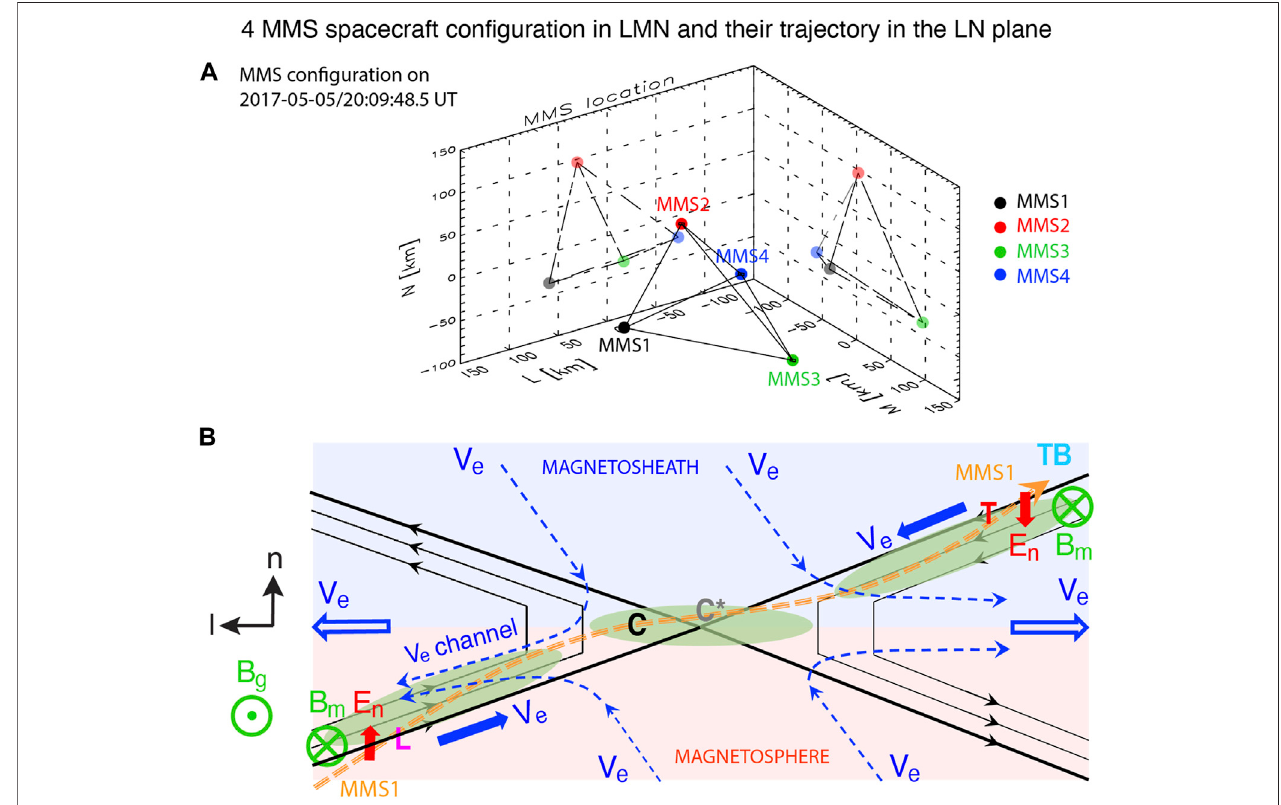
FIGURE2|(A) Thetetrahedralcon fi gurationofthefourMMSspacecraftarounditsbarycenterat( − 13.9, − 17.9, − 4.8) GSM Earthradii(R E )on2009:48/5 UT; (B) the illustration of the trajectory of MMS1 (the dashed orange arrow) across the reconnection plane, where “ L ” , “ C ” , “ C* ” , and “ T ” correspond to those shown at the top of Figure 3